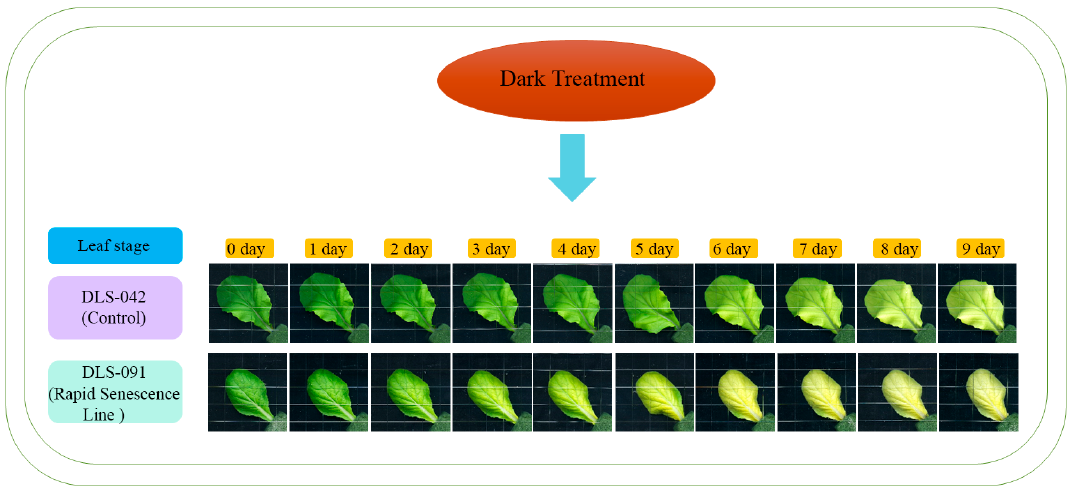
Figure 1. Dark induced leaf senescence in DLS-42 and DLS-91. Leaf senescence is divided into three phases: I (days 0–3), II (days 4–6), and III (days 7–9).